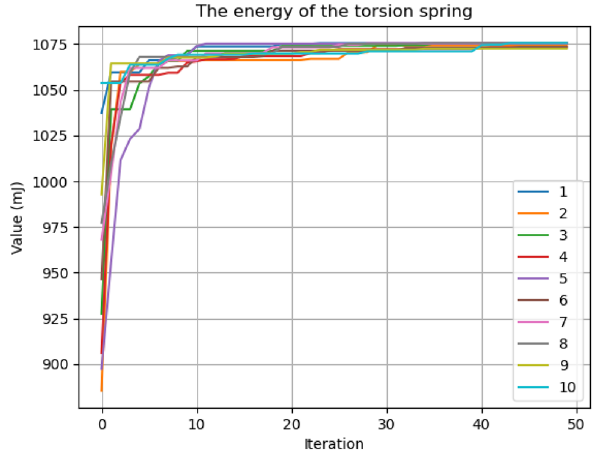
Figure 6. Optimization results for torsion spring—Scenario 2.